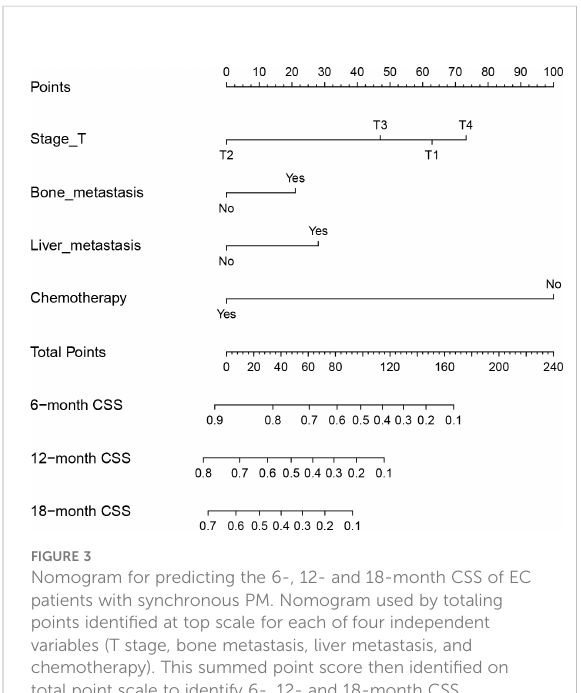
FIGURE 3 Nomogram for predicting the 6-, 12- and 18-month CSS of EC patients with synchronous PM. Nomogram used by totaling points identi fi ed at top scale for each of four independent variables (T stage, bone metastasis, liver metastasis, and chemotherapy). This summed point score then identi fi ed on total point scale to identify 6-, 12- and 18-month